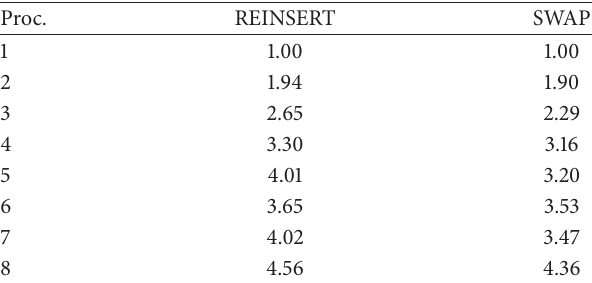
Table 11: Speed-up: 𝑁 (𝑅) with random start. Proc.